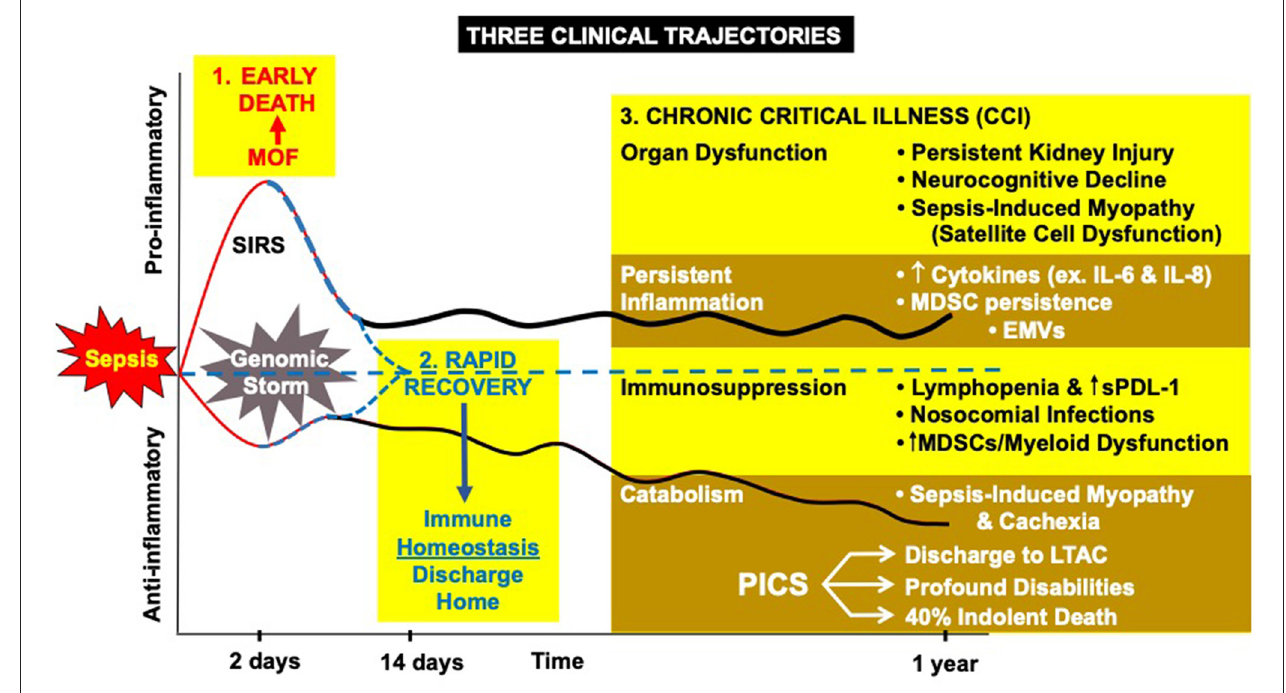
FIGURE 1 | The host response to severe sepsis can have three different clinical trajectories: (1) early MOF leading to death, (2) rapid recovery, or (3) the new appearance of chronic critical illness (CCI) characterized by organ dysfunction, inflammation, immune suppression, and protein catabolism. MDSC, myeloid derived suppressor cells; EMVs, endothelial microvesicles; sPDL-1, soluble protein death ligand 1; LTAC, long-term acute care